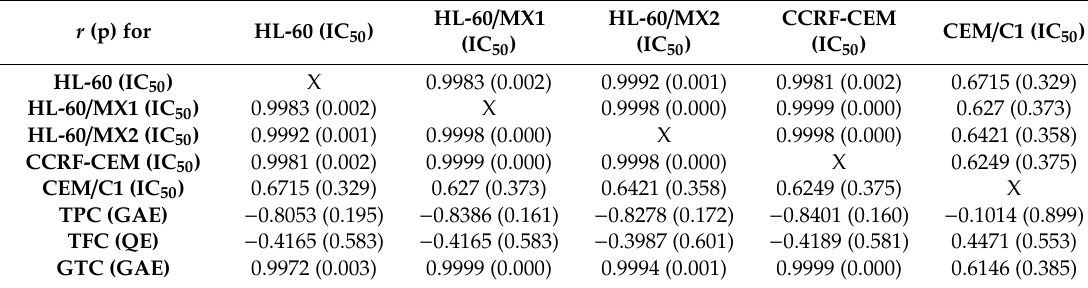
Table 4. Pearson’s correlation coe ffi cients between phenolic content and cytotoxicity of